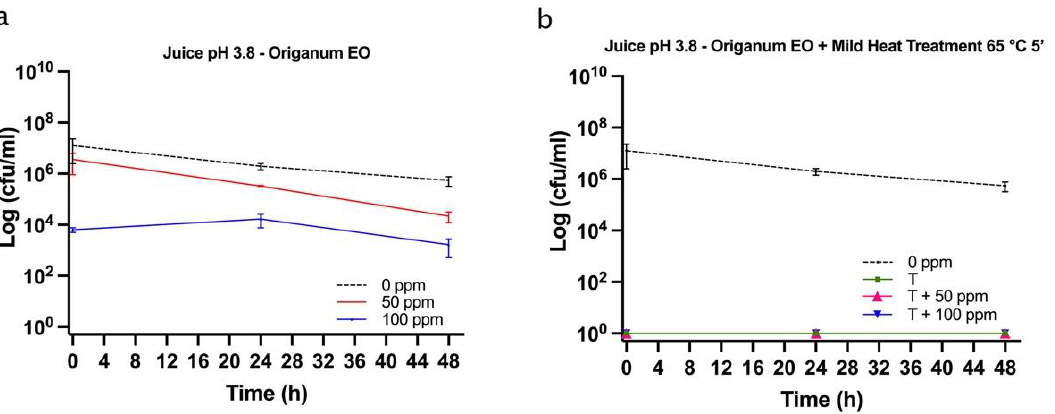
Figure 9. E. coli cell load in fruit juice of pH 3.8 plated on MacConkey agar (Log CFU/mL). ( a ) OEO (0, 50, and 100 ppm) treatment and ( b ) thermal treatment 65 °C 5 min alone and combined with OEO (50 and 100 ppm).